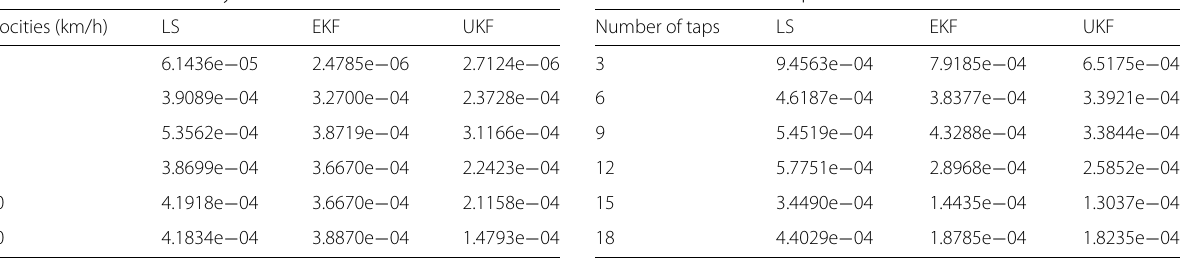
Table 4 The variance for BEM-based channel estimation methods in different